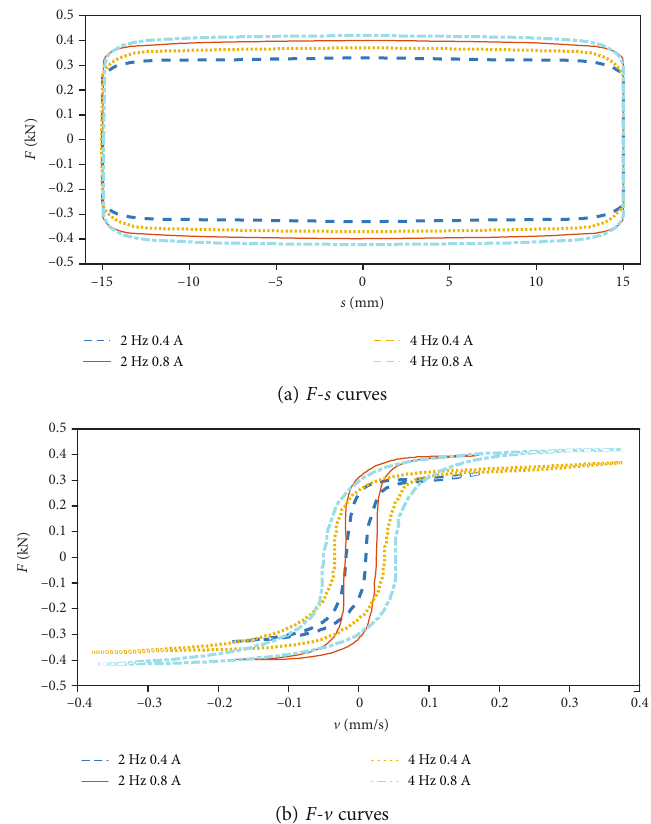
Figure 6: F - s curves and F - v curves at di ff erent input frequencies under 15 mm and 0.4A and